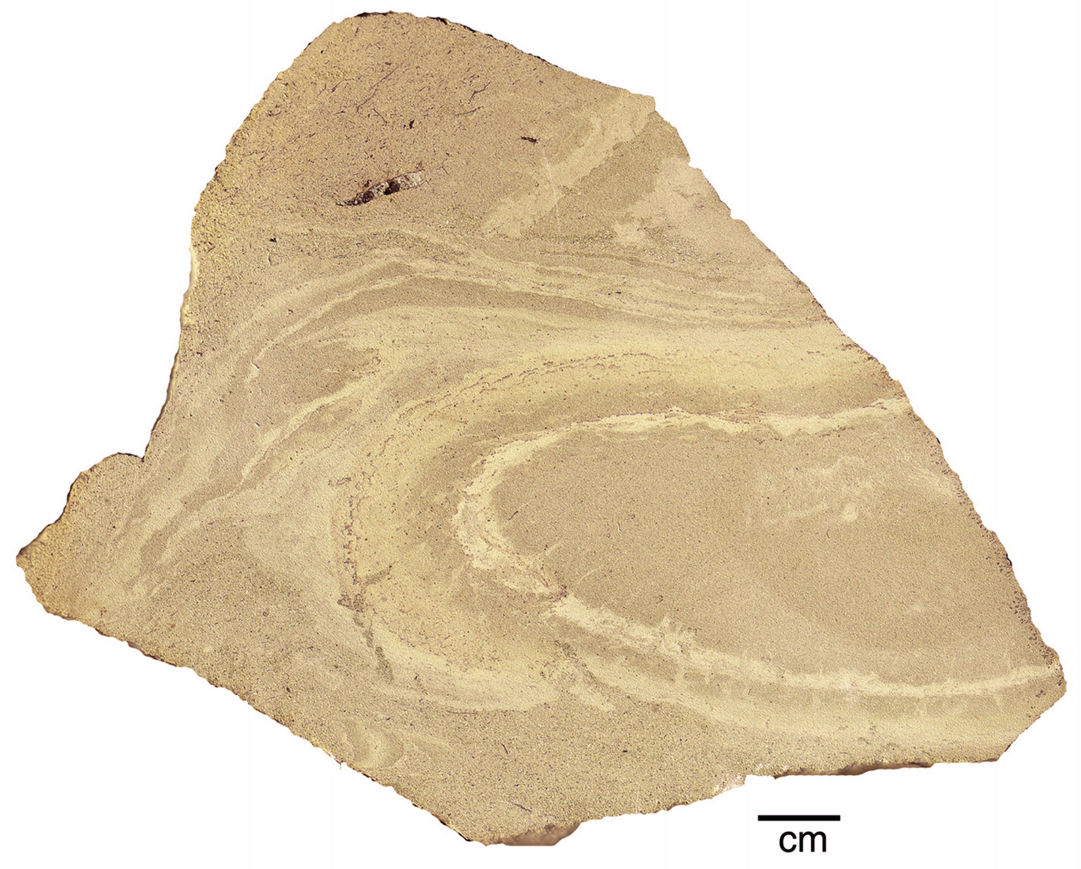
Figure 11. Sawn surface of mudstone from Corner Lot locality showing soft sediment deformation. (specimen